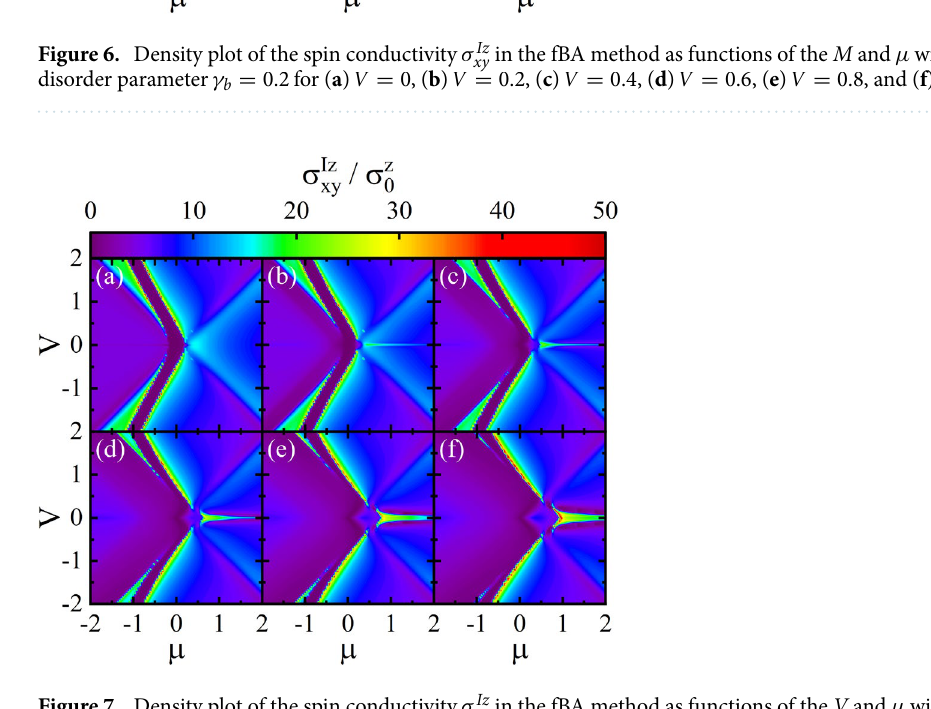
Figure 7. Density plot of the spin conductivity σ Iz xy in the fBA method as functions of the V and µ with the disorder parameter γ b = 0.2 for ( a ) M = 0 , ( b ) M = 0.2 , ( c ) M = 0.4 , ( d ) M = 0.6 , ( e ) M = 0.8 , and ( f ) M = 1